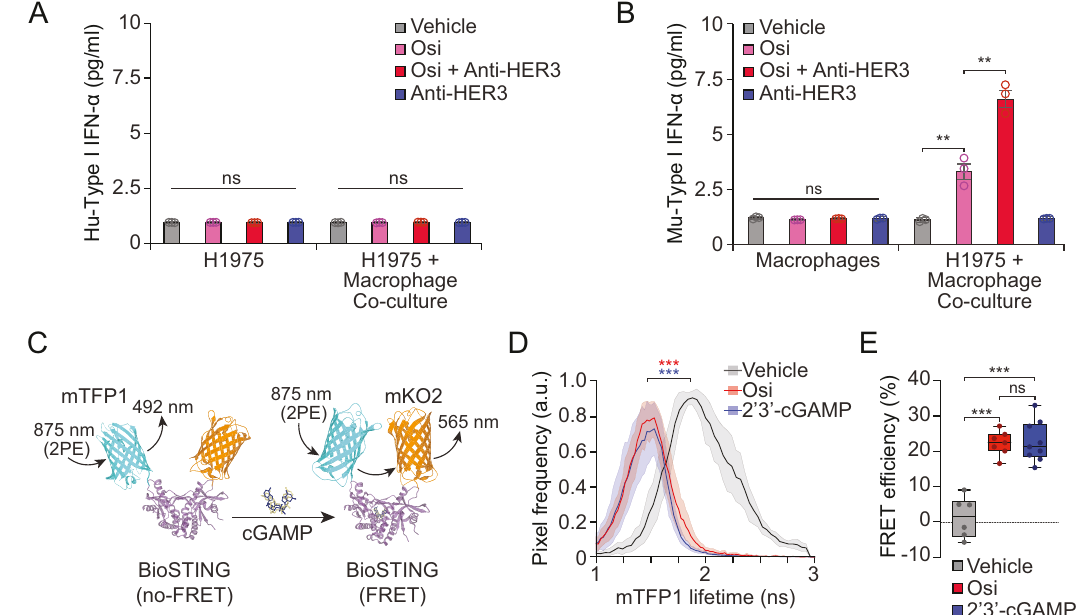
Fig. 6 Osimertinib increases cGAMP production in tumor cells leading to type-I IFN production in macrophages. A Quanti fi cation of H1975-derived human type-I IFN. H1975 cells pre-treated with osimertinib (200 nM, 24 h) were treated with anti-HER3 (MP-RM-1, 10 μ g/ml, 1 h) and then either co-cultured with bone marrow derived macrophages (BMDMs, 24 h, ratio 10:1) or maintained for 24 h; supernatants were assessed for ELISA as described in materials and methods. Data are shown as mean ± SEM from 3 independent experiments. Non-signi fi cant (ns) differences calculated using unpaired t -test. B Quanti fi cation of macrophage-derived murine type-I IFN. Supernatants from macrophages treated as indicated (24 h) or co-cultured with H1975 cells as described for Panel A , were assessed for ELISA as described in materials and methods. Data shown as mean ± SEM from 3 independent experiments. ** P < 0.01 as indicated, using unpaired t -test. C Diagram illustrating the recombinant biosensor BioSTING, composed of cyclic di-nucleotide (CDN) binding domain (CBD, purple) of STING linked to teal fl uorescent protein (mTFP1 at L152) and to orange fl uorescent protein (mKO2 at E335), which upon 2-photon excitation (2PE) undergoes Förster resonance energy transfer (FRET) when bound to the CDN cGAMP. D H1975 cells stably expressing BioSTING were treated with pixel distribution vs . lifetime (ns), average values ± 95% con fi dence interval shown as lines and spectrum respectively. Data generated from 6 single cell acquisitions per condition (min) was used to generate a normalised summed plot. *** P < 0.001 as indicated by colour vs . vehicle, using Kolmogrov-Smirnov 2 sample test. E Quanti fi cation of FRET ef fi ciency from the experiments described in panel D, indicating cGAMP production in H1975 cells after osimertinib treatment. Data shown as box plots of FRET ef fi ciencies (median ± IQR & interval whiskers). *** P < 0.001 as indicated, using unpaired t